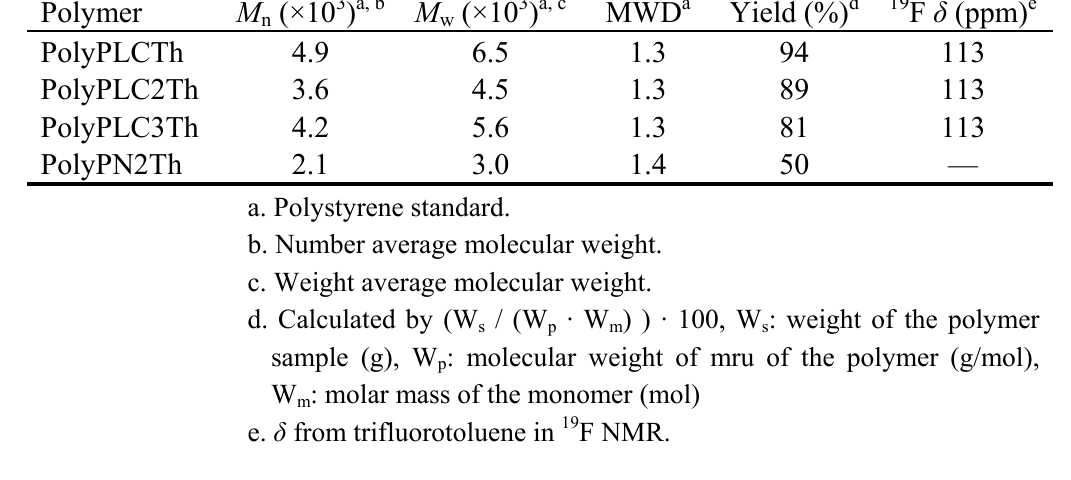
Figure 3. FT-IR spectra of the polymers. PolyPLCTh (a) , polyPLC2Th (b) , polyPLC3Th (c) , polyPN2Th (d)